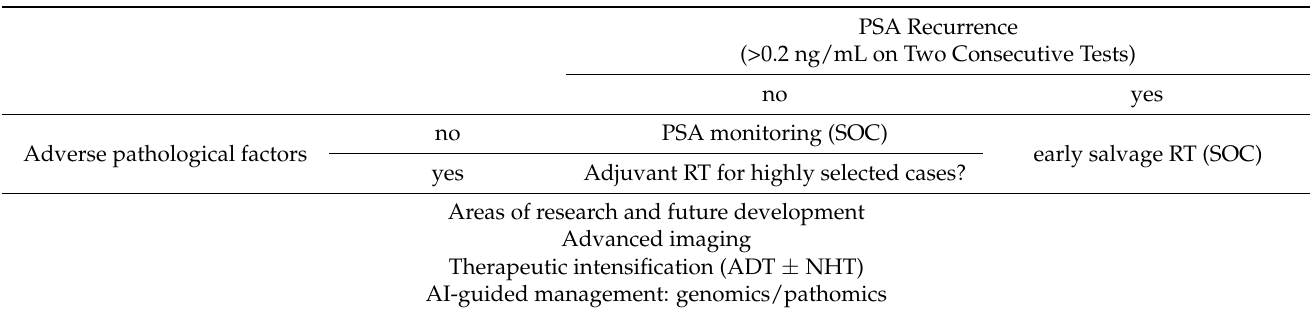
Table 4. The management of BCR after RP: an overview of current status and trends. PSA Recurrence (>0.2 ng/mL on Two Consecutive Tests) no yes no PSA monitoring (SOC) Adverse pathological factors early salvage RT (SOC) yes Adjuvant RT for highly selected